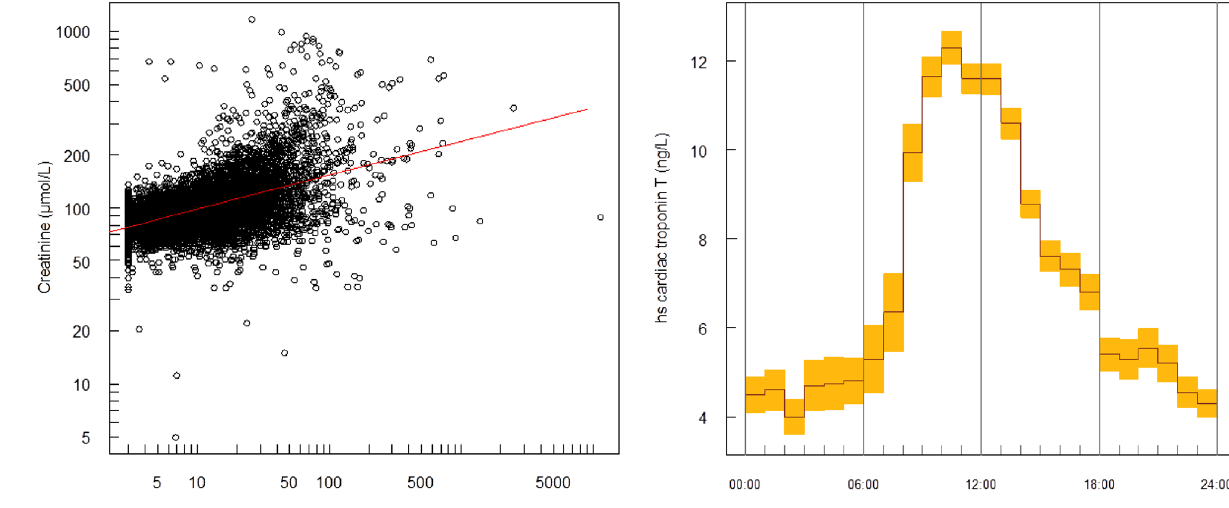
during the morning at 8:30 and a minimum at 20:30 of 11.9. tween the peak and the nadir of cTnT concentration ranging from 3.4 to 11.8 ng/L depending on the start